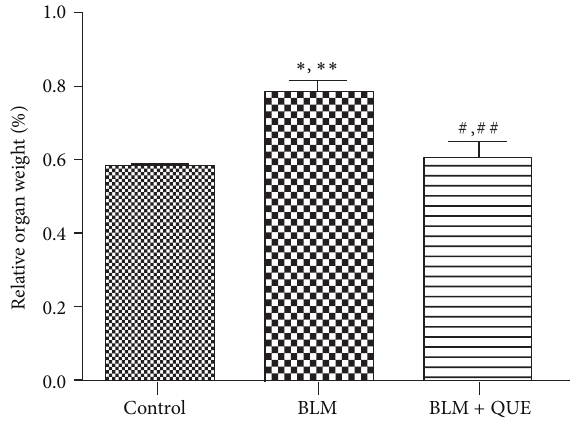
Figure 2: Relative weight of rat lung on day 21 of treatment. 𝑛 = 6 . ∗ 𝑃 ≤ 0.05 , ∗∗ 𝑃 ≤ 0.01 versus control group. # 𝑃 ≤ 0.05 , ## 𝑃 ≤ 0.01 versus bleomycin group.